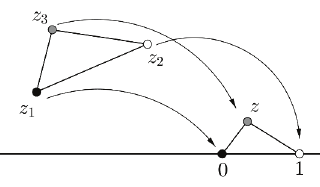
can be attached to the segment (0 , 0) and (1 , 0) in twelve ways. ,z ,z 1 2 3